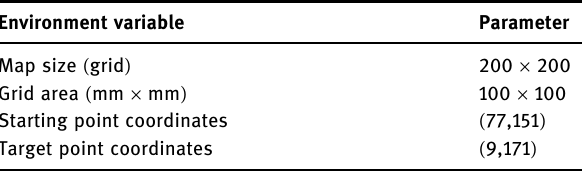
Table 1: Environment and task parameters